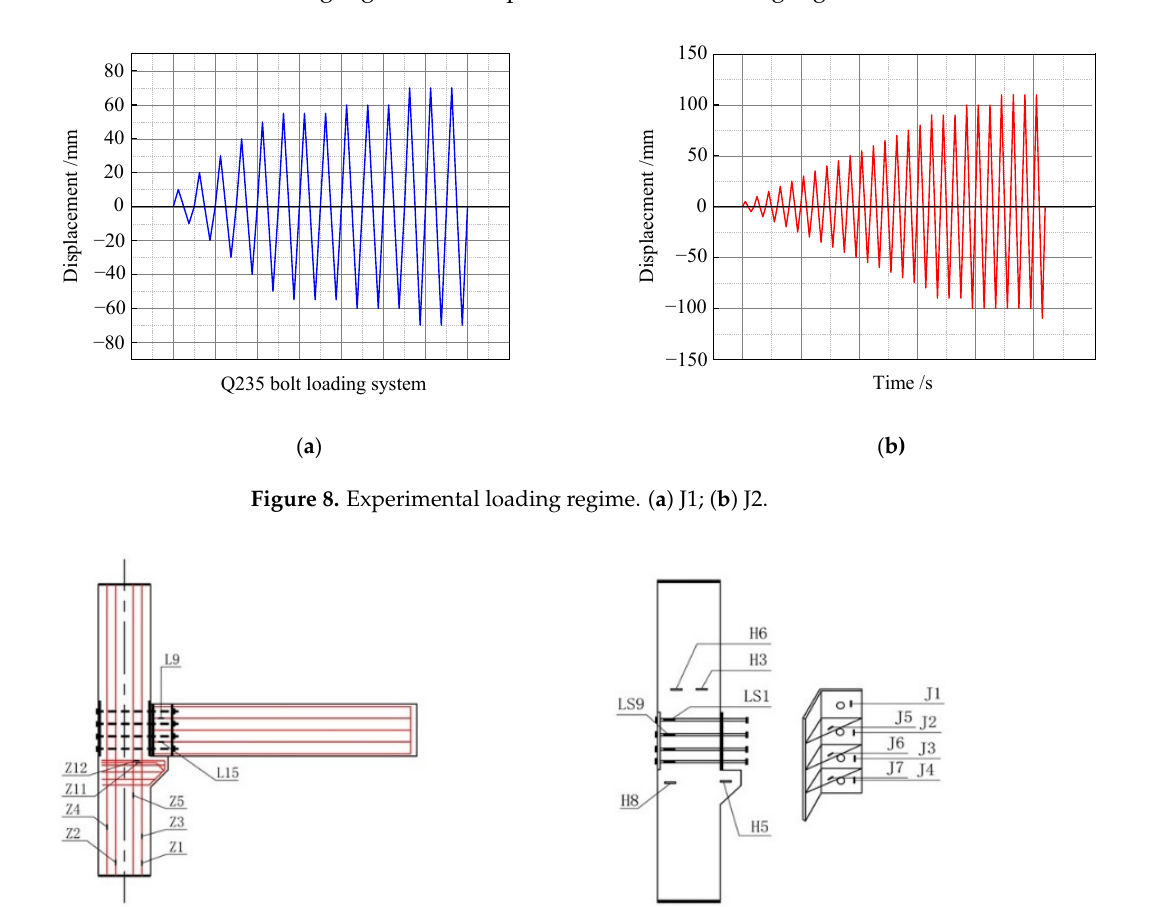
Figure 10. Location of test specimen displacement gauge. The pressure sensor, displacement meter, and strain gauge (Please see Table 6) used the Donghua DH3818Y collection box for data collection, and the pressure sensor was connected to the full bridge. The displacement was measured as a linear displacement sensor, and the access mode was the half bridge. Before preloading, the pressure sensor and the displacement sensor were calibrated according to their respective sensitivities, and their sensitivity coefficients were 0.131 and 0.668, respectively. The strain gauge ac- cess mode was 1/4 bridge (public compensation); the acquisition frequency of the acqui- sition box was 2 HZ. A picture of the collection box and linear displacement sensor is shown in Figure 11.